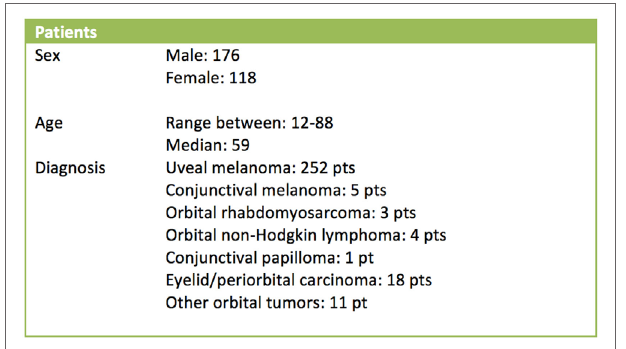
FIgURe 8 | Characteristics of the treated